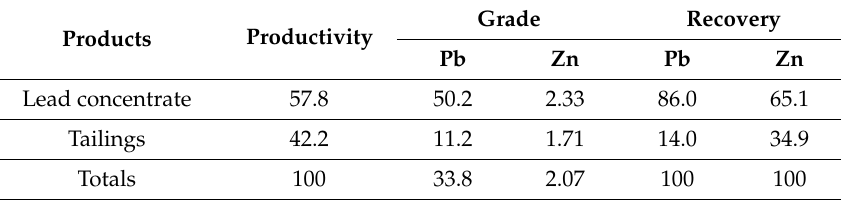
Figure 8. Scheme for recovering lead from the leaching residue. Table 7. Results of lead recovery lead from the leaching residues (wt %).